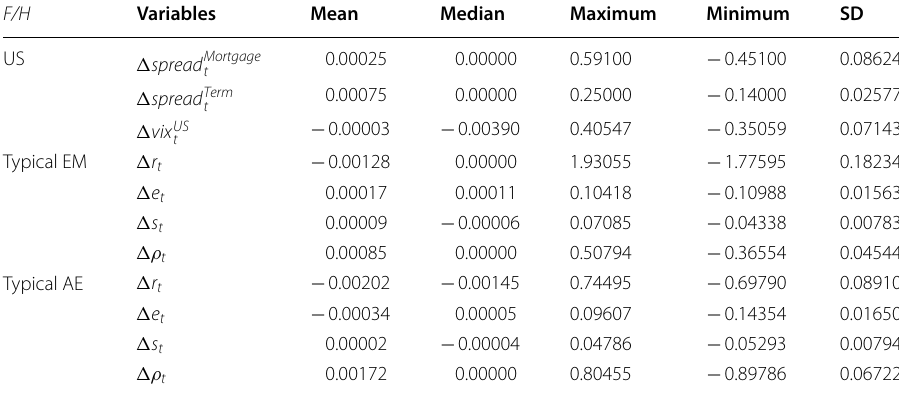
Table 2 Descriptive statistics of